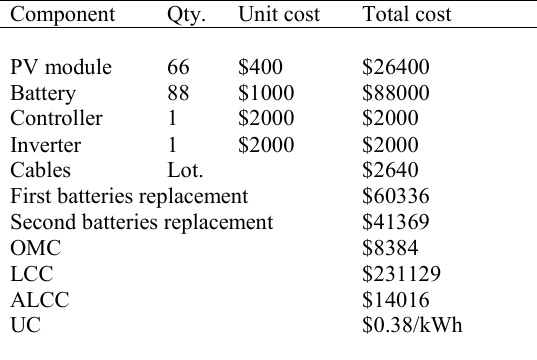
Table 11: Cost estimate of the PV system